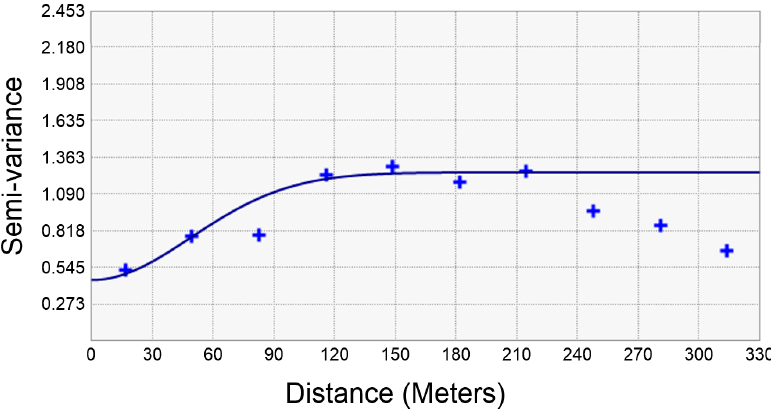
Figure 8. Experimental variogram modeling of Cu content in the study area.